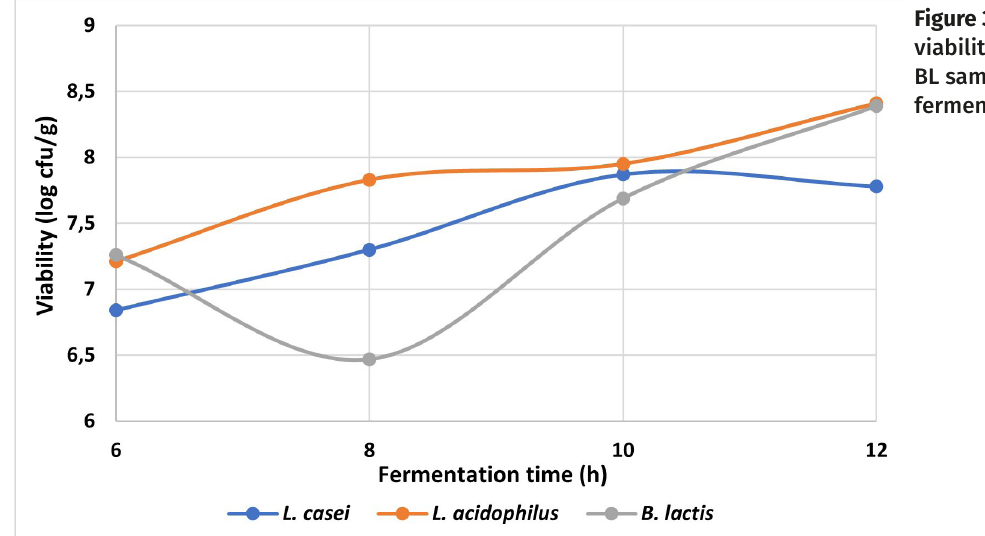
Figure 3. Probiotic viability of LC, LA and BL samples during the